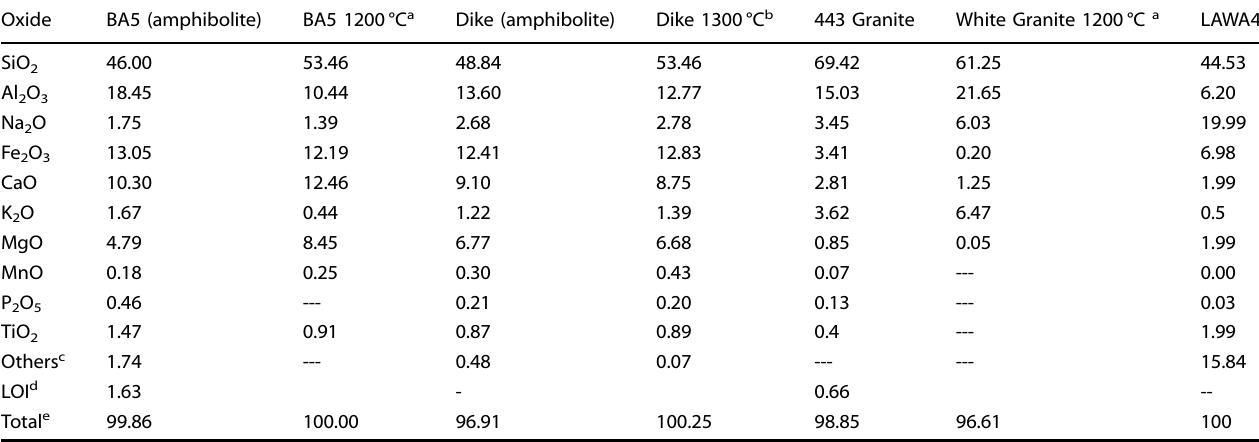
Table 1. Measured composition determined through a chemical digestion of BA5 amphibolite, Dike amphibolite, and 443 Granite, along with a representative low-activity waste glass (LAWA44) 36